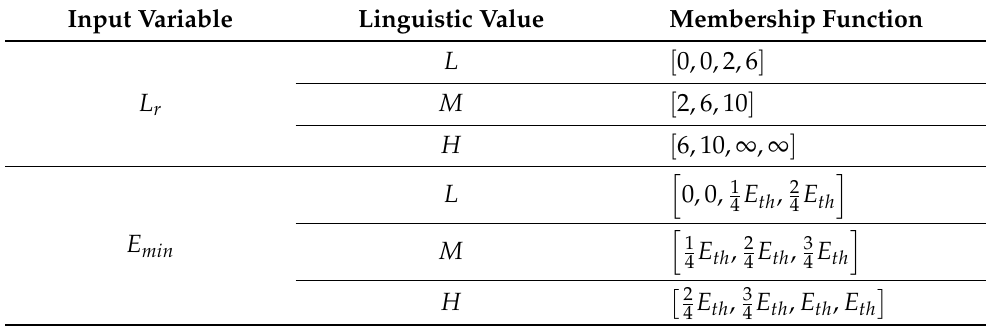
(cid:16) (cid:17) 0.1 − 2 E th E max